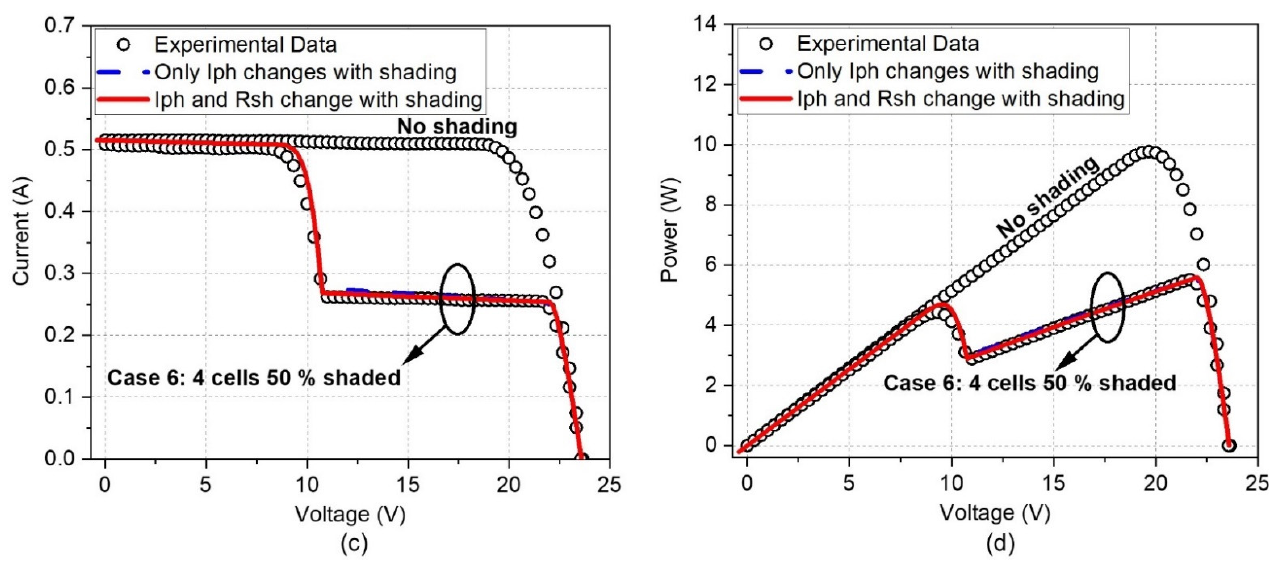
Figure 11. Experimental and calculated I-V and P-V curves of the 10 W PV module for cases 5 and 6. The black circles are experimental results. The red solid lines represent the calculated results that consider the variations of both I ph and R sh . The blue dashed lines represent the calculated results that consider the variation of I ph only: ( a ) I-V curve of case 5; ( b ) P-V curve of case 5; ( c ) I-V curve of case 6; ( d ) P-V curve of case 6. Each experimental curve is the average of three measurements under a light irradiance of 1000 W/m 2 measured at the centre of the module at a module temperature of 25 ◦